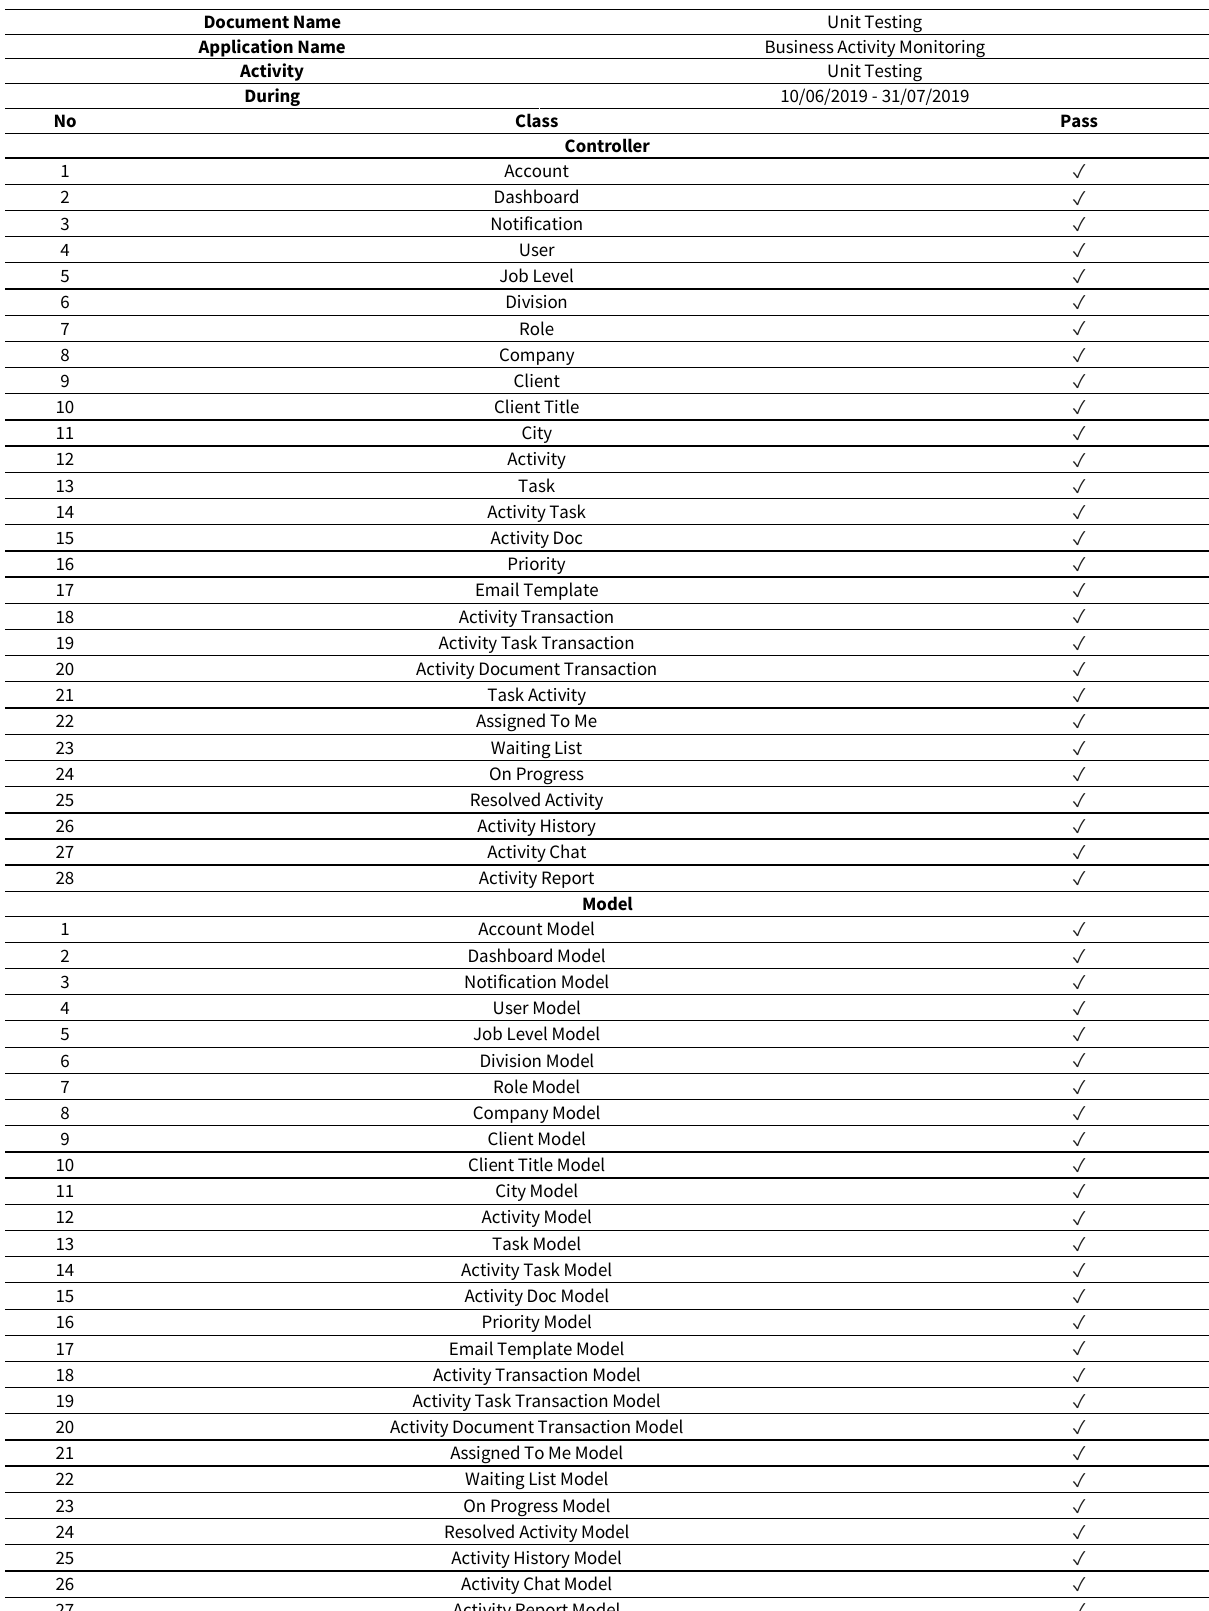
Table 5. Result of Unit